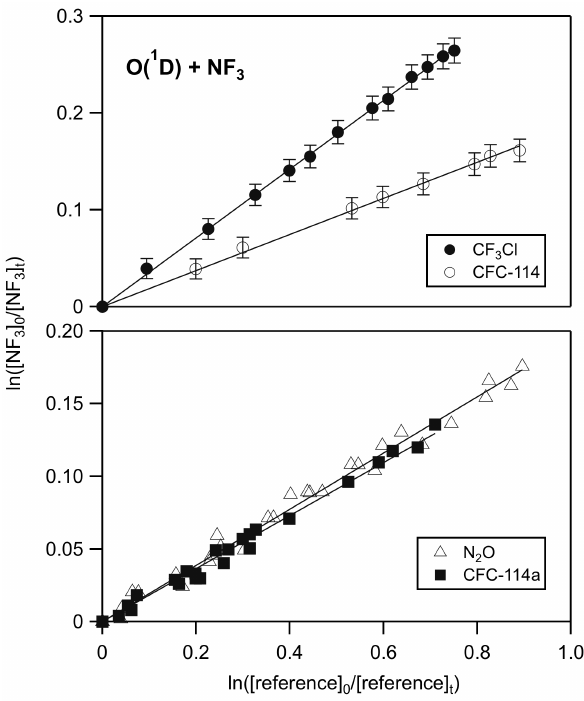
Fig. 2. Reactive rate coefficient data for the O( 1 D) + NF 3 re- action at 296K with CF 3 Cl, CF 2 ClCF 2 Cl (CFC-114), N 2 O, and CF 3 CFCl 2 (CFC–114a) as the reference compounds. The error bars on the data points (top panel) represent an estimated uncertainty in the infrared spectral analysis, ± 1% of the initial reactant concen- tration. Error bars are omitted in the bottom panel for improved clarity. The N 2 O and CF 3 CFCl 2 (CFC-114a) data are a combina- tion of two separate experiments. The lines are linear least-squares fits to the data. The results are given in Table